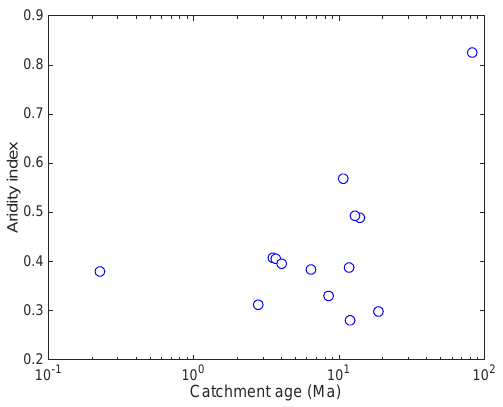
Figure 6. Slope of flow–duration curves with catchment age ( R = 0 . 74, p = 0 . 002).